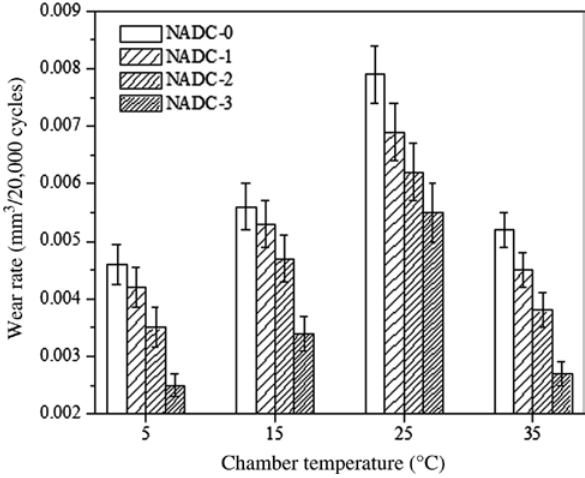
Figure 7: Effect of chamber temperature on volumetric wear rate of the dental composites in food slurry condition (at constant normal load of 40 N and chewing speed of 5 mm/s).